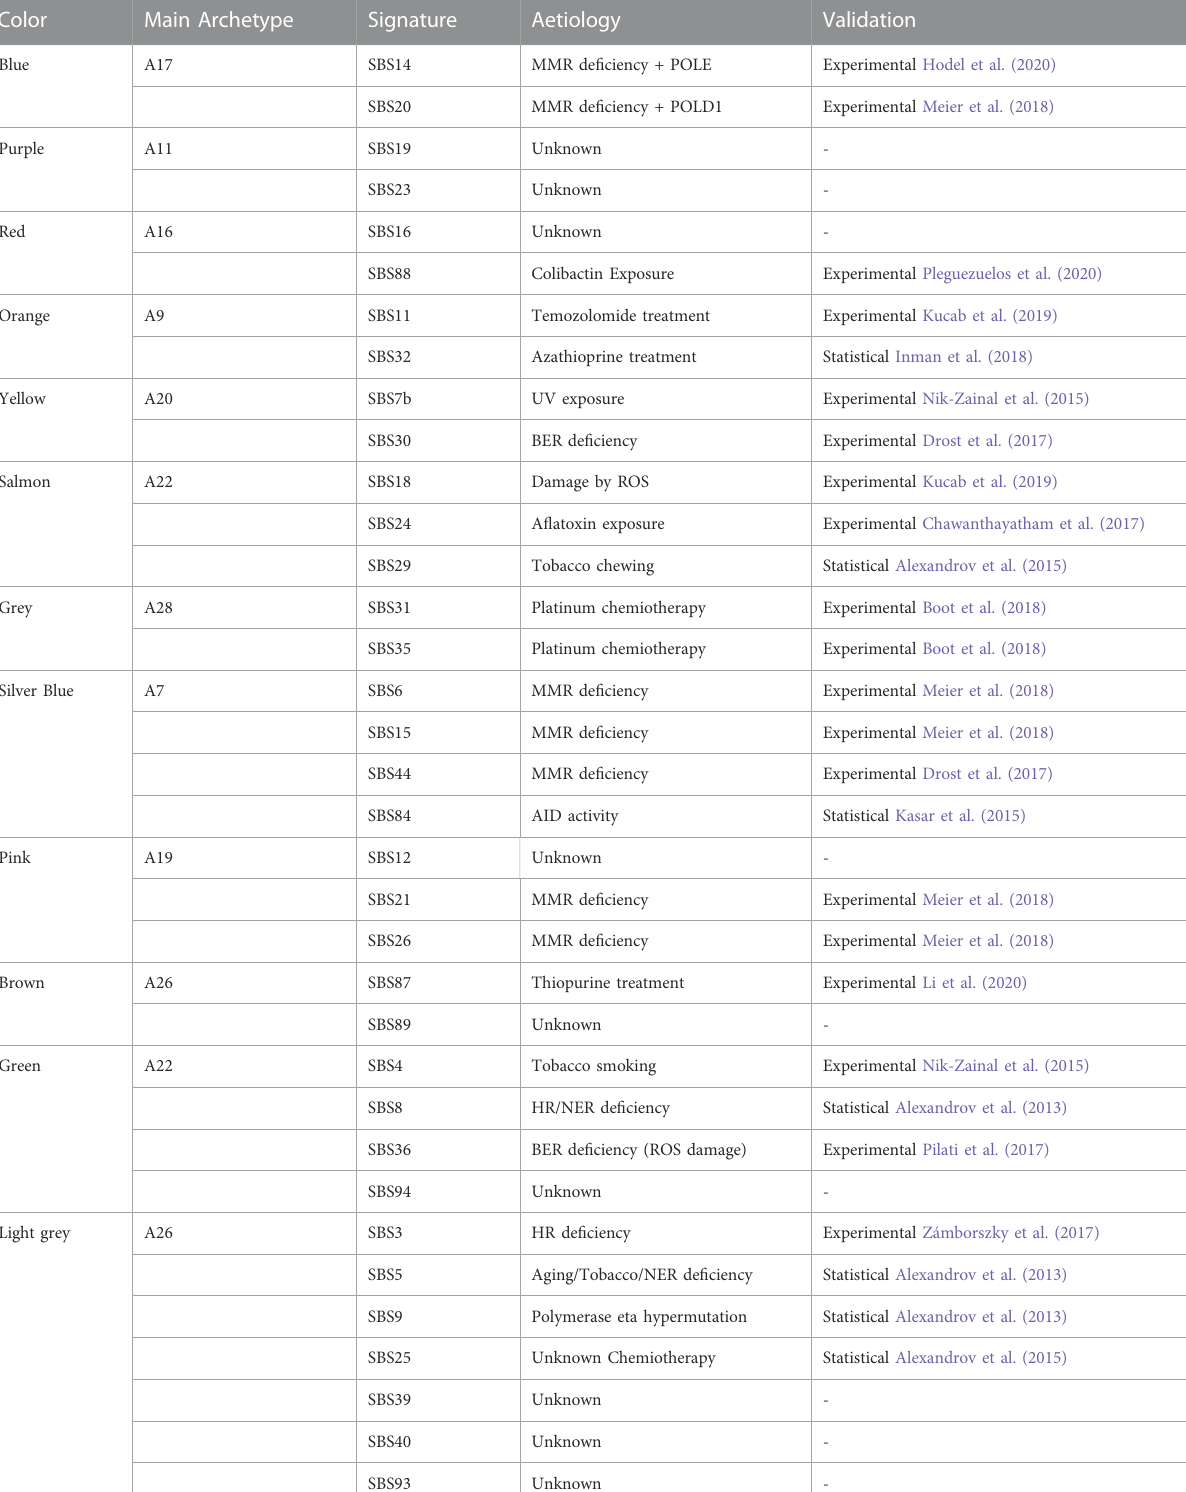
TABLE 3 Aetiological information related to each archetype. For each archetype, the corresponding reconstructed signatures and, when available, their associated aetiologies are reported, indicating the validation studies supporting the biological